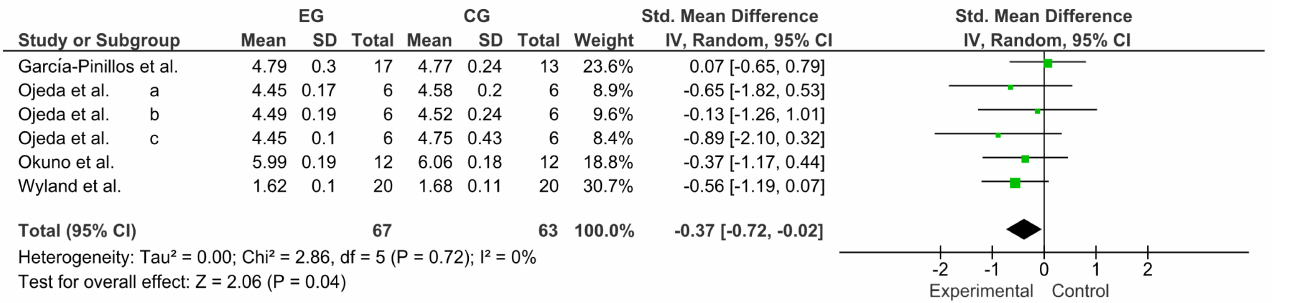
( C ) Figure 4. The standard error for throwing speed ( A ), time in sprint tests ( B ), and jump height ( C ). SE: standard error; SMD: standardized median difference. 3.5. Effect of VR on Throwing Speed Two studies were considered for this analysis [40,47]. The research by Ojeda et al. [40] was considered as four independent studies for performing four comparisons (1a, 1b, 1c, and 1d). Consequently, to calculate the effect of VR on throwing speed, this meta- analysis considered the five comparisons as independent studies. Figure 5 shows the trivial effect of VR on throwing speed (SMD = 0.06; CI = 95%: − 0.23–0.35; p = 0.69). The meta-analysis showed low heterogeneity among the studies reviewed (I 2 = 0%; p = 0.65).